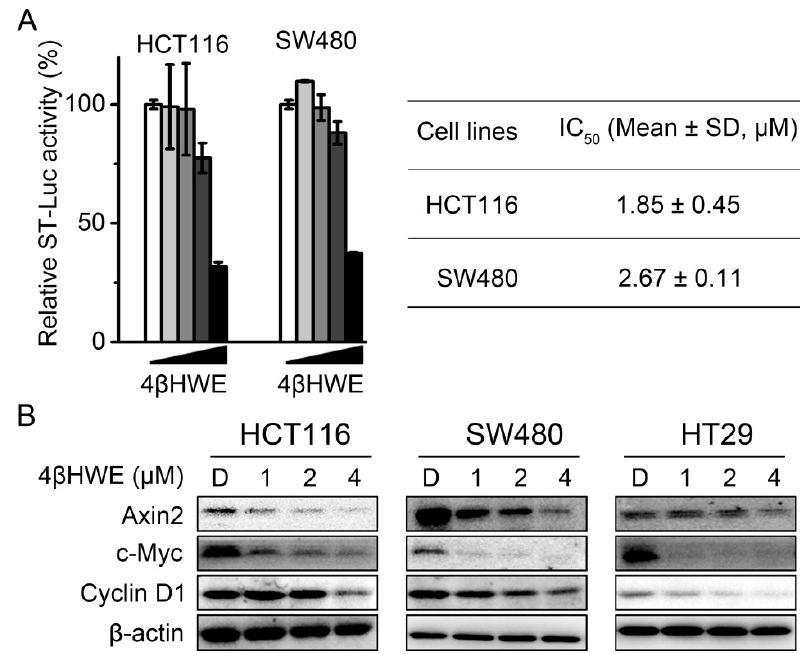
Figure 2. 4 β HWE suppresses the endogenous Wnt signaling pathway in colorectal cancer (CRC). ( A ) HCT116 and SW480 cells were treated with 0.0064, 0.032, 0.16, 0.8 and 4 µ M of 4 β HWE for 24 h, and the Wnt signaling inhibitory activity of 4 β HWE was measured with the dual-luciferase reporter assay. The values represent the mean ± SD ( n = 3). ( B ) Western blot analysis of lysates from HCT116, SW480, and HT29 cells treated with DMSO (D), 1, 2 and 4 µ M 4 β HWE for 24 h.